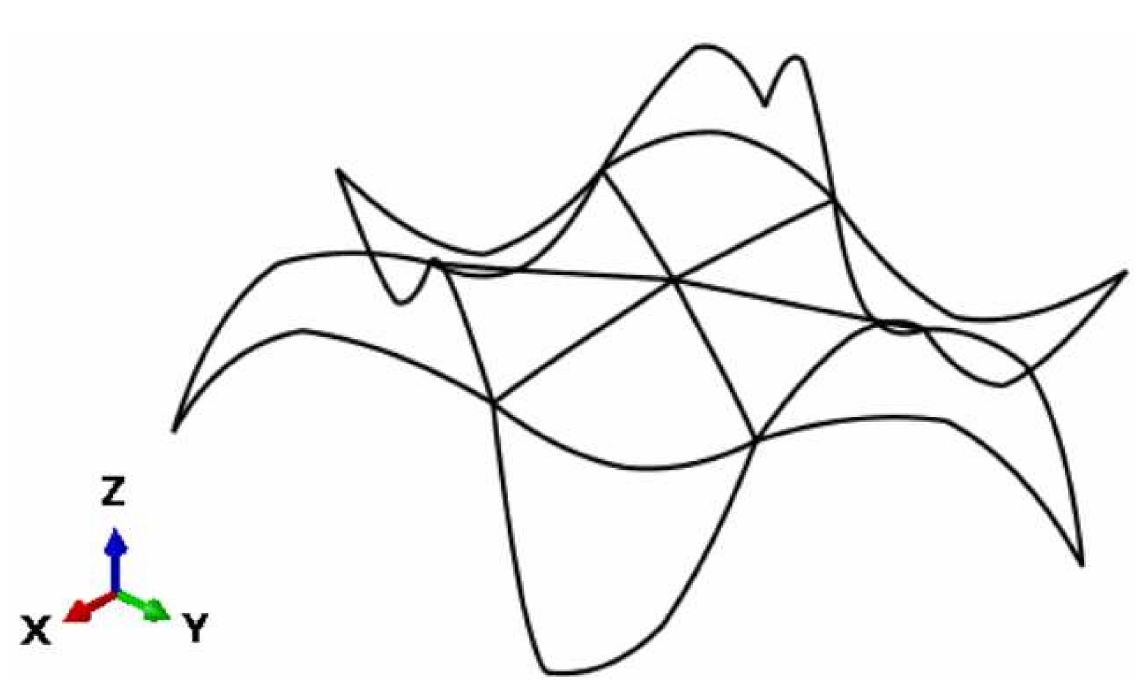
Figure 7. Dome 2—imaginary part of the first nonlinear eigenvector (values multiplied by